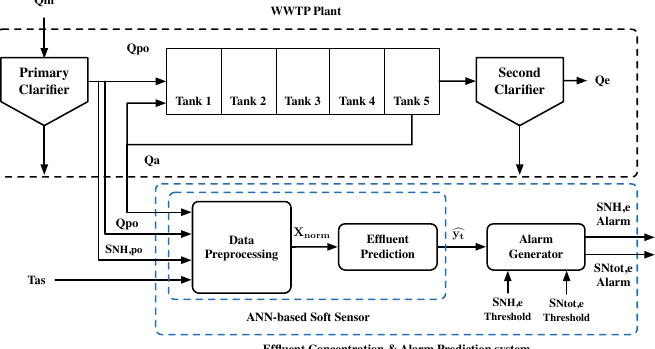
Figure 7. Effluent Concentrations and Alarm Prediction System (ECAPS) system. It generates an alarm whenever a violation of S NH , e or S Ntot , e limits is